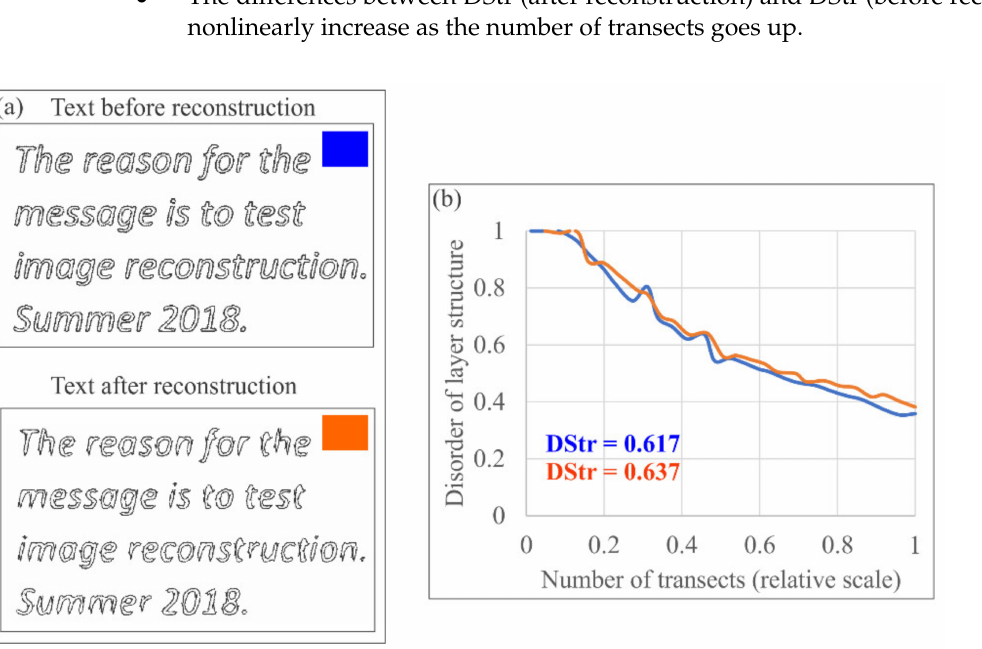
Figure 6. Text as binary pattern. Pattern reconstruction from its empirical model. ( a ) Text before and after reconstruction. ( b ) Disorder of structure for the text pattern before and after